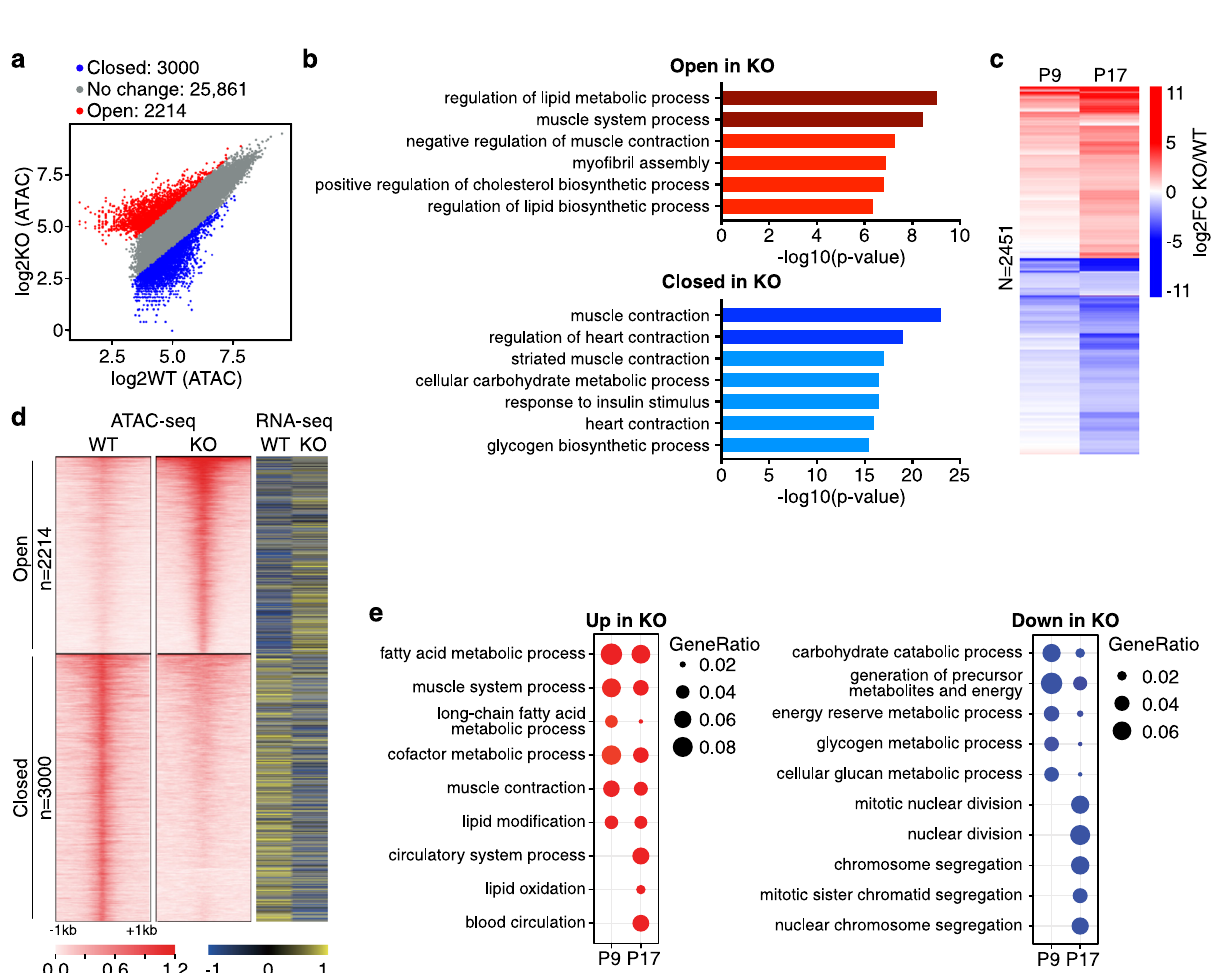
Fig. 3 Loss of Net39 causes changes in chromatin accessibility and gene expression. a Scatter plot with all detected peaks in P17 quadriceps ATAC-seq ( n = 3). A cutoff of fold change >2 and an adjusted p value <0.05 by Benjamini and Hochberg procedure for multiple comparisons was set for the identi fi cation of differentially open and closed peaks in Net39 KO samples. b Pathways enriched by GREAT analysis of open or closed chromatin peaks in Net39 KO samples compared to WT. c Heatmap showing fold change of upregulated and downregulated genes in KO muscle at P9 ( n = 3) and P17 ( n = 3) as determined by RNA-seq. A cutoff of fold change >2 and an adjusted p value <0.05 by Benjamini and Hochberg procedure for multiple comparisons was set for the identi fi cation of differentially expressed genes. Color scale represents Z -score. d Heatmap of open- and closed-regulated ATAC-seq peaks (left panels) and the expression level of associated genes as determined by RNA-seq (right panel). Color scale represents Z -score. e GO terms enriched among upregulated (left) and downregulated (right) genes by RNA-seq. Circle sizes indicate the ratio of genes included in the